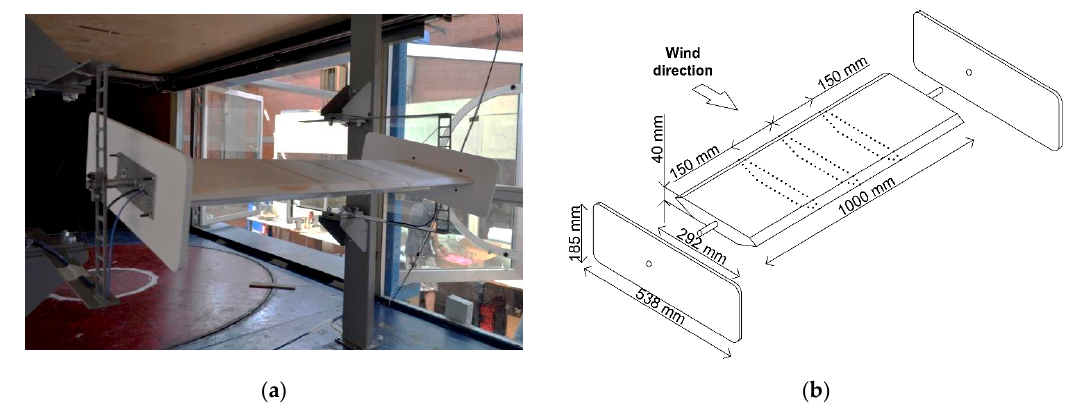
Figure 3. Aerodynamic tests: experimental setup ( a ), pressure tap positions ( b ) [20].